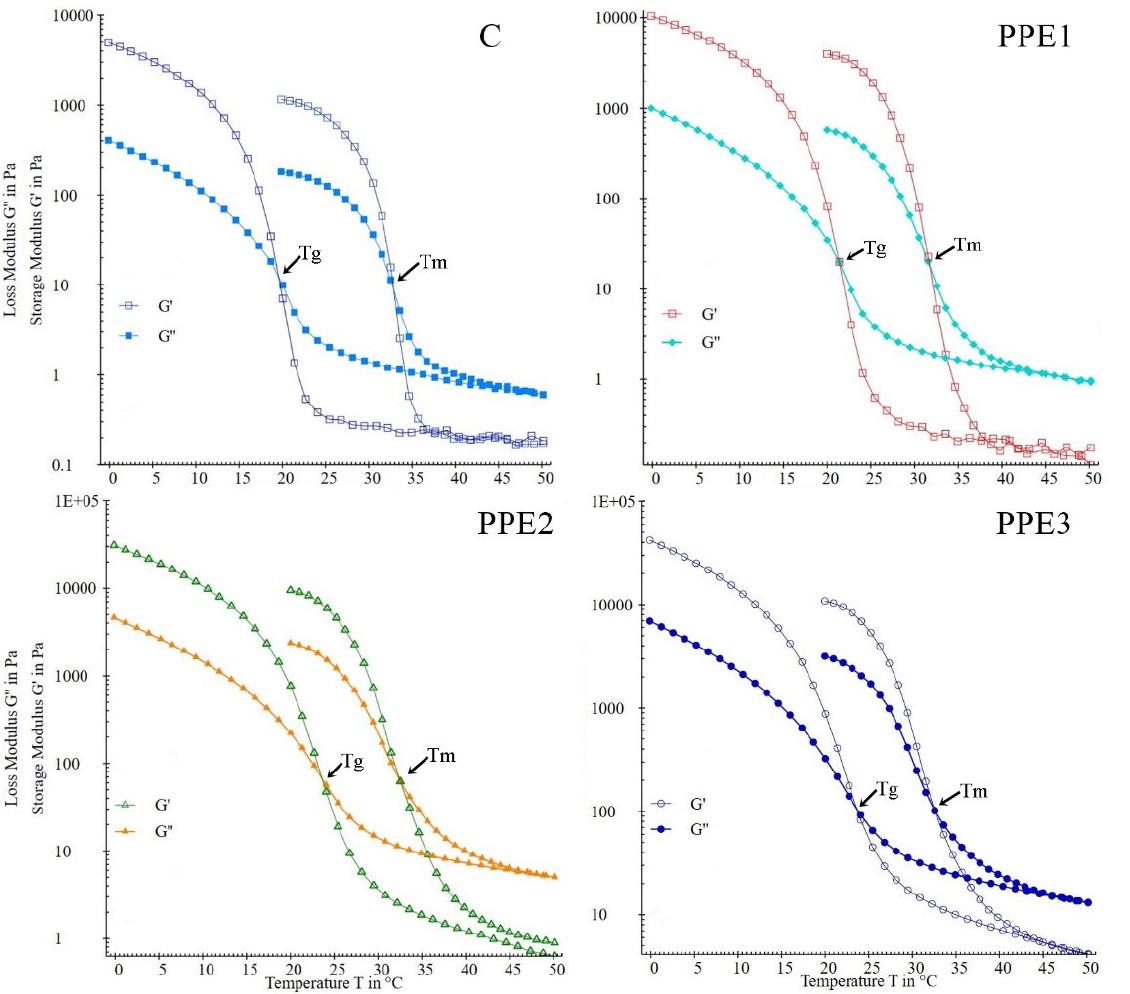
Figure 2. Effects of pomegranate peel extract (PPE) concentration on the storage (G’) and loss (G’’) modulus of gelatin/sodium alginate composite solutions during heating and cooling process. (C: Control, without PPE; PPE1: gelatin/sodium alginate solution with 1% PPE; PPE2: gelatin/sodium alginate solution with 2% PPE; PPE3: gelatin/sodium alginate solution with 3% PPE; T m : Melting temperature (°C); T g : Gelation temperature (°C)). Table 1. The melting and gelation temperatures of “Boba” mix and bioactive properties of “Boba balls”.